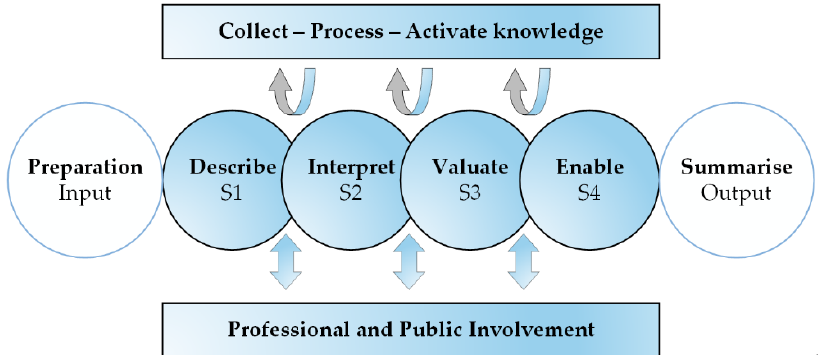
Figure 1. Structure of the DIVE approach.